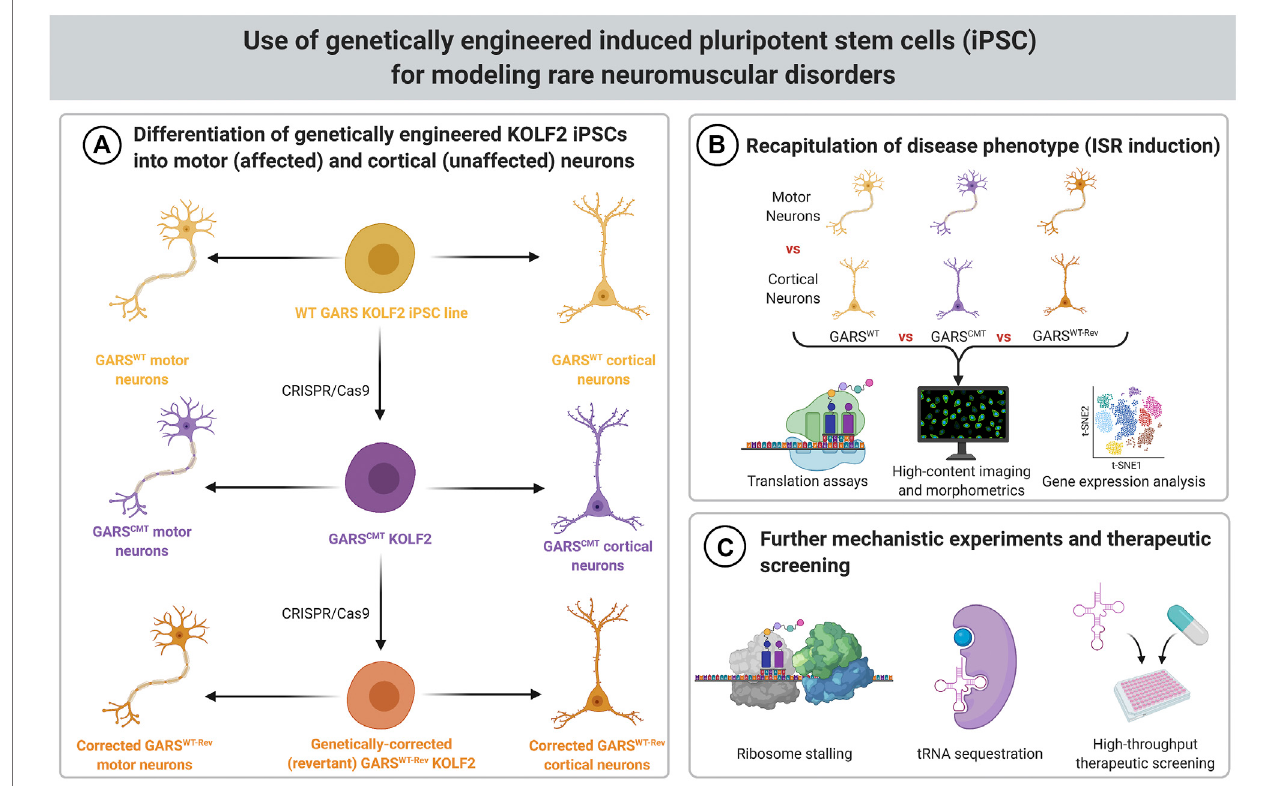
FIGURE 2 | Schematic for modeling rare neuromuscular disorders using genetically engineered iPSCs. (A) KOLF2 iPSCs genetically engineered to carry CMT- associated GARS mutations can be differentiated into motor neurons, which are affected by CMT, and cortical neurons, which are not affected by CMT. The wild-type parental cells and revertant cells (which have had the introduced GARS mutation corrected back to WT) can be used as controls. (B) Translation assays, high content imaging and morphometrics, and gene expression analysis can be used to determine if the ISR is activated in GARS mutant motor neurons. (C) If motor neurons have the expected phenotype (ISR induction), then they can be used for further mechanistic experiments, such as ribosome stalling assays and analysis of biochemical properties of tRNA sequestration. These cells can also be used for high-throughput screens of therapeutics.